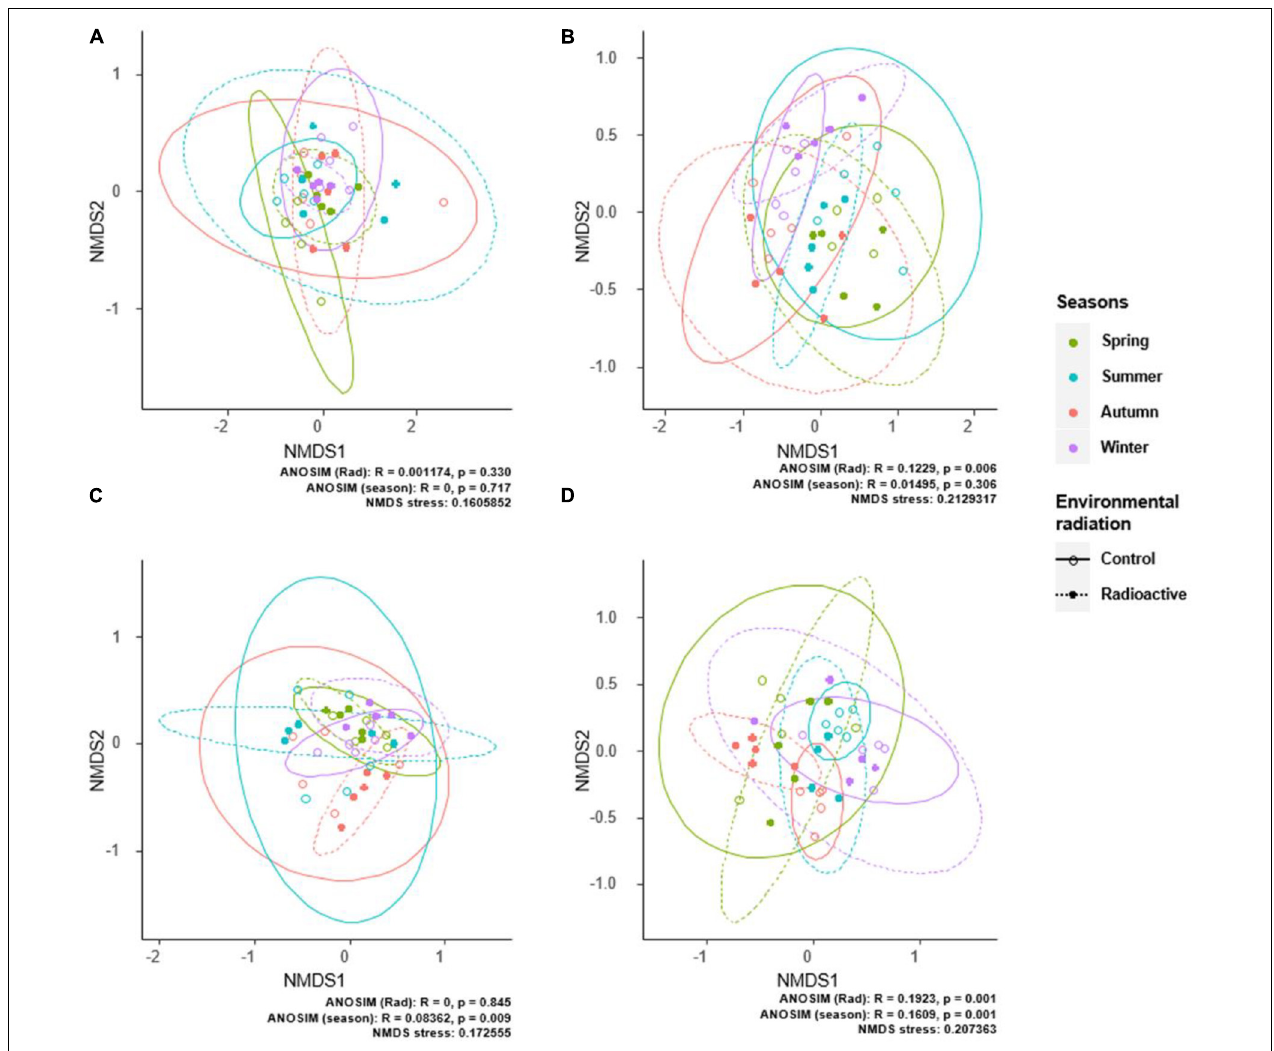
FIGURE 5 | The differences in endophytic microbial communities are demonstrated by non-metric multidimensional scaling ordination. The differences in bacterial communities in aerial tissues (A) or roots (C) , and fungal communities in aerial tissues (B) or roots (D) are shown by seasons and sites. Ellipses denote 95% confidence intervals for the centroids of each group. Analysis of similarities analysis indicates significant differences in bacterial and fungal communities between seasons and radiation